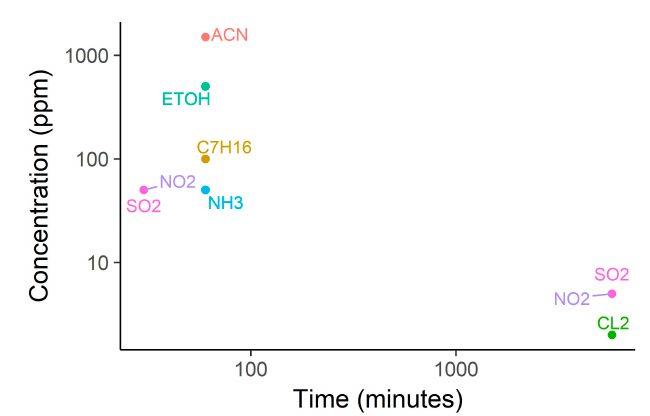
Figure 5. Concentration and exposure time of the different interferent gases that appear in the standard ISO7240. Note the log scale. Specifically, the concentrations and exposure times are: 5 ppm of NO 2 at 96 h and 50 ppm at 30 min, 5 ppm of SO 2 at 96 h and 50 ppm at 30 min, 2 ppm of Cl 2 at 96 h, 50 ppm of NH 3 at 1 h, 100 ppm of Heptane at 1 h, 500 ppm of Ethanol at 1 h and 1500 ppm of Acetone at 1 h.